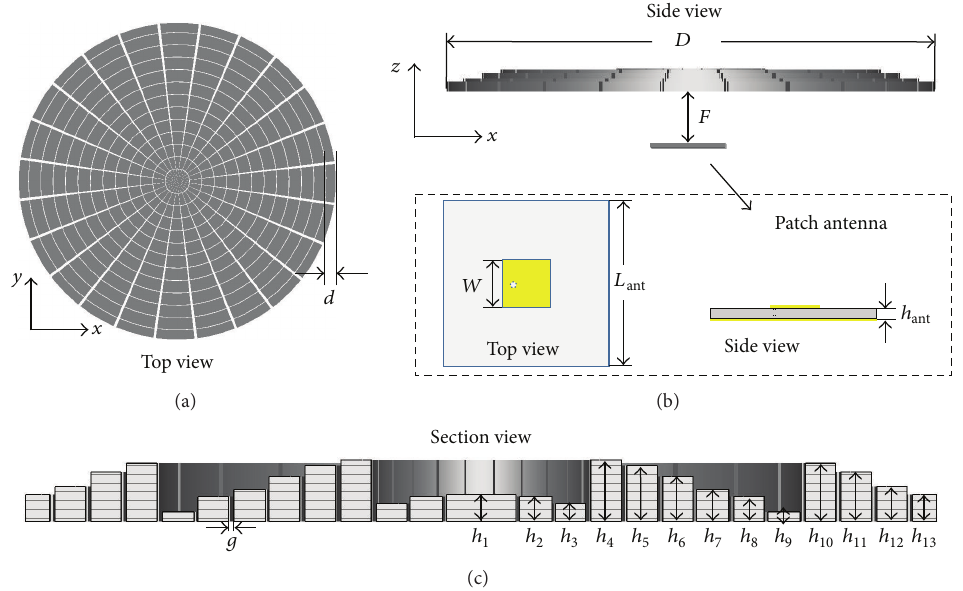
Figure 4: The detailed geometry of the ultra-low-profile lens antenna system, which is composed of a clapped dielectric metasurface and a patch antenna. The geometry of the lens: 𝑑 = 4mm, ℎ 1 = 3.05 mm, ℎ 2 = 2.78 mm, ℎ 3 = 2.00 mm, ℎ 4 = 6.84 mm, ℎ 5 = 6.20 mm, ℎ 6 = 5.04 mm, ℎ ℎ ℎ ℎ ℎ ℎ 𝑔 = 0.2 mm. The focal length ℎ 7 = 3.56 mm, 8 = 2.76 mm, 9 = 1.11mm, 10 = 6.45mm, 11 = 5.50 mm, 12 = 3.84 mm, 13 = 3.00 mm, and = 17mm, and ℎ and the diameter of the lens are 𝐹 = 15mm and 𝐷 = 102mm, respectively. The geometry of the antenna: 𝑤 = 4.6 mm, 𝐿 ant ant = 0.813